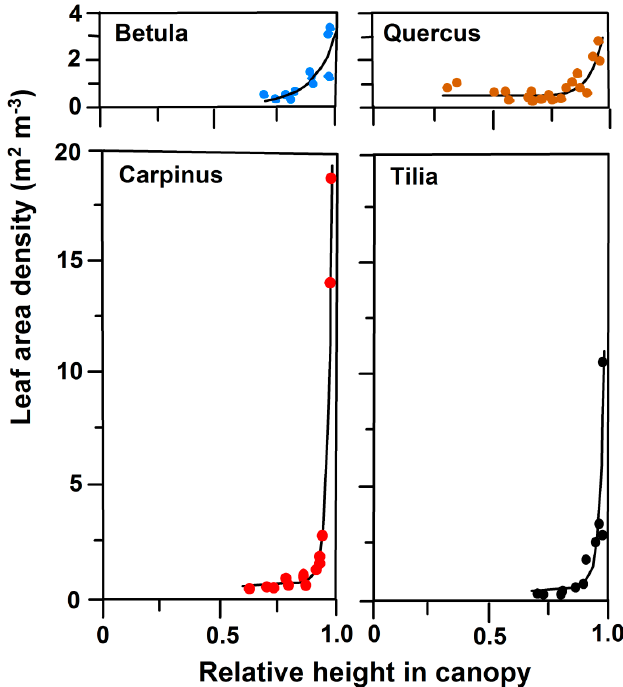
Figure 6. Leaf area density (leaf area per crown volume) in dependence on height in the crown of the five tree species. The data were calculated from measured crown volume (crown window data) and the corresponding leaf areas per volume and height level as determined for each of the four harvested tree individuals per species. No data available for Fagus . Parameters of the exponential equations of the form y = a + b x c : Betula : a = 0.142, b = 2.91, c = 9.02; Quercus : a = 0.524, b = 3.93, c = 17.78; Carpinus : a = 3, b = 36.9, c = 42.1; Tilia : a = 0.447, b = 13.8, c =